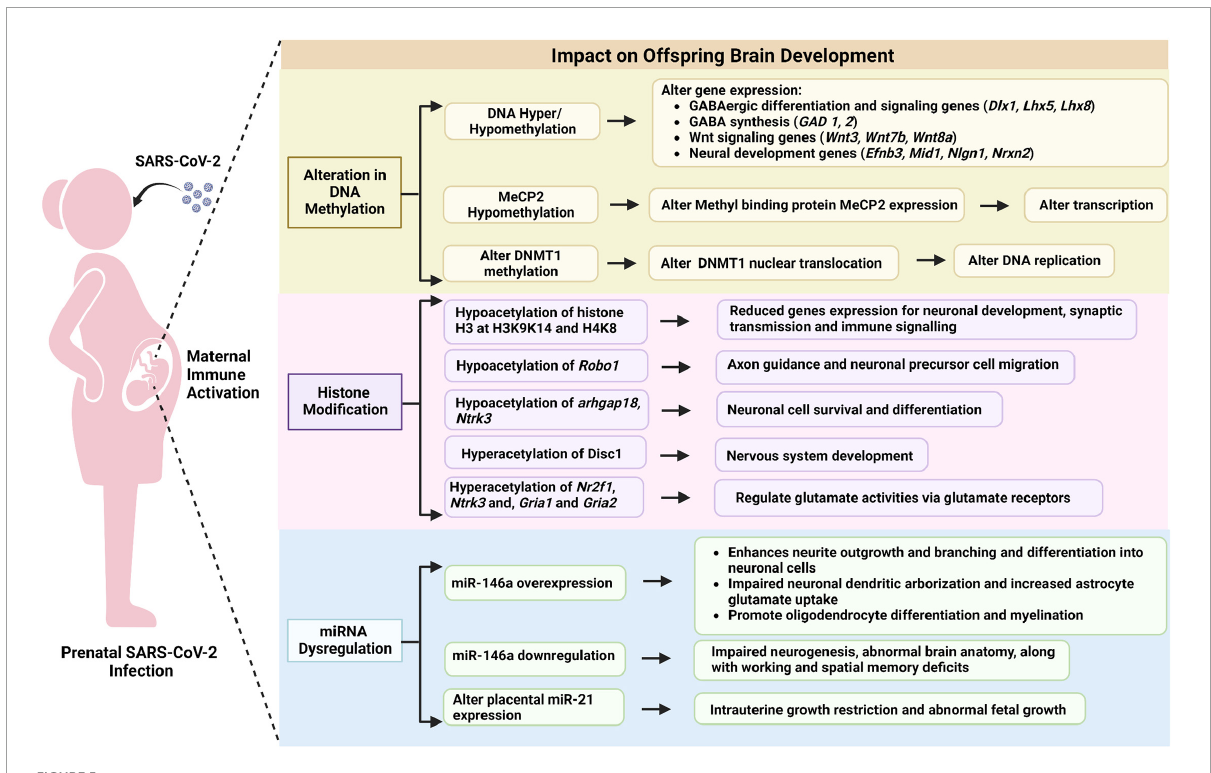
FIGURE5 Potential epigenetic mechanisms linking prenatal SARS-CoV-2 infection to offspring brain